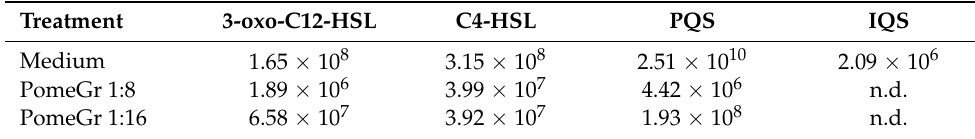
Table 1. AI release by P. aeruginosa exposed or not to PomeGr. Treatment